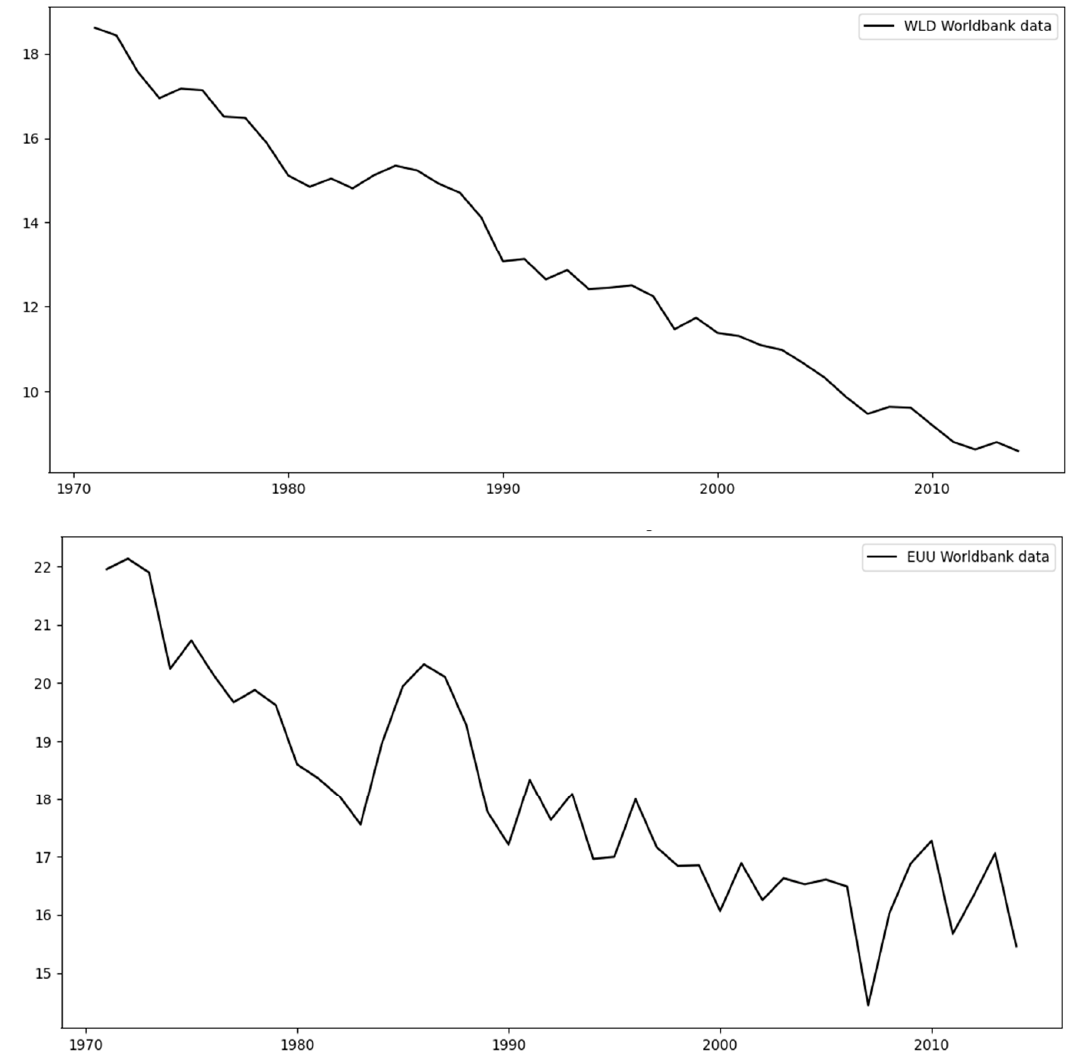
Figure 3. Original data for India (IND), China (CHN), the USA, the world (WLD), and the European Union (EUU) covering the period between 1971–2014. The vertical axis shows the level of CO 2 emissions from buildings expressed as a percentage of fuel combustion (datasets provided by the World Bank).